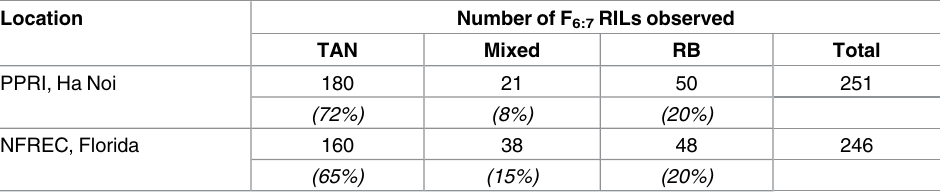
Table 1. Reactions to soybean rust observed on F 6:7 recombinant inbred lines (RILs) derived from a Williams 82 × DT 2000 cross and the parental lines in the field at the Plant Protection ResearchInsti- tute (PPRI), Ha Noi, Vietnam, and at the North Florida Researchand Education Center (NFREC), Quincy, Florida, USA, in 2008. Tan-colored (TAN) reactions indicatesusceptibilityand reddish-brown (RB) lesionsindicate resistance. Mixed reactions might have resultedfrom the presenceof multiplefungal patho- types, residual heterozygosity, or a combination of these factors. Most RILs showedthe similar reactionsto rust at both